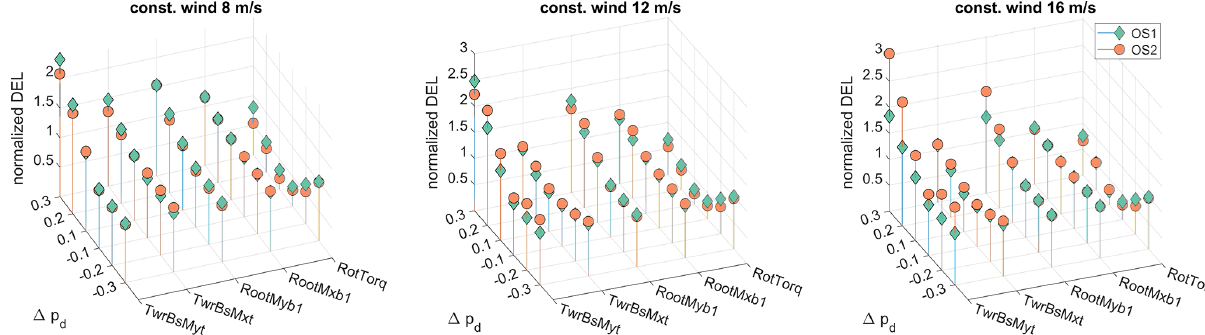
Figure 5. Comparison of normalized ultimate loads for stepwise variation in power demand (cid:49)p d = {− 0 . 3 , − 0 . 2 , − 0 . 1 , 0 . 1 , 0 . 2 , 0 . 3 } oper- ated in different constant winds. The results are normalized to the ultimate load occurring for a step of (cid:49)p d = − 0 . 3 in OS1 for each of the considered ultimate loads and winds.